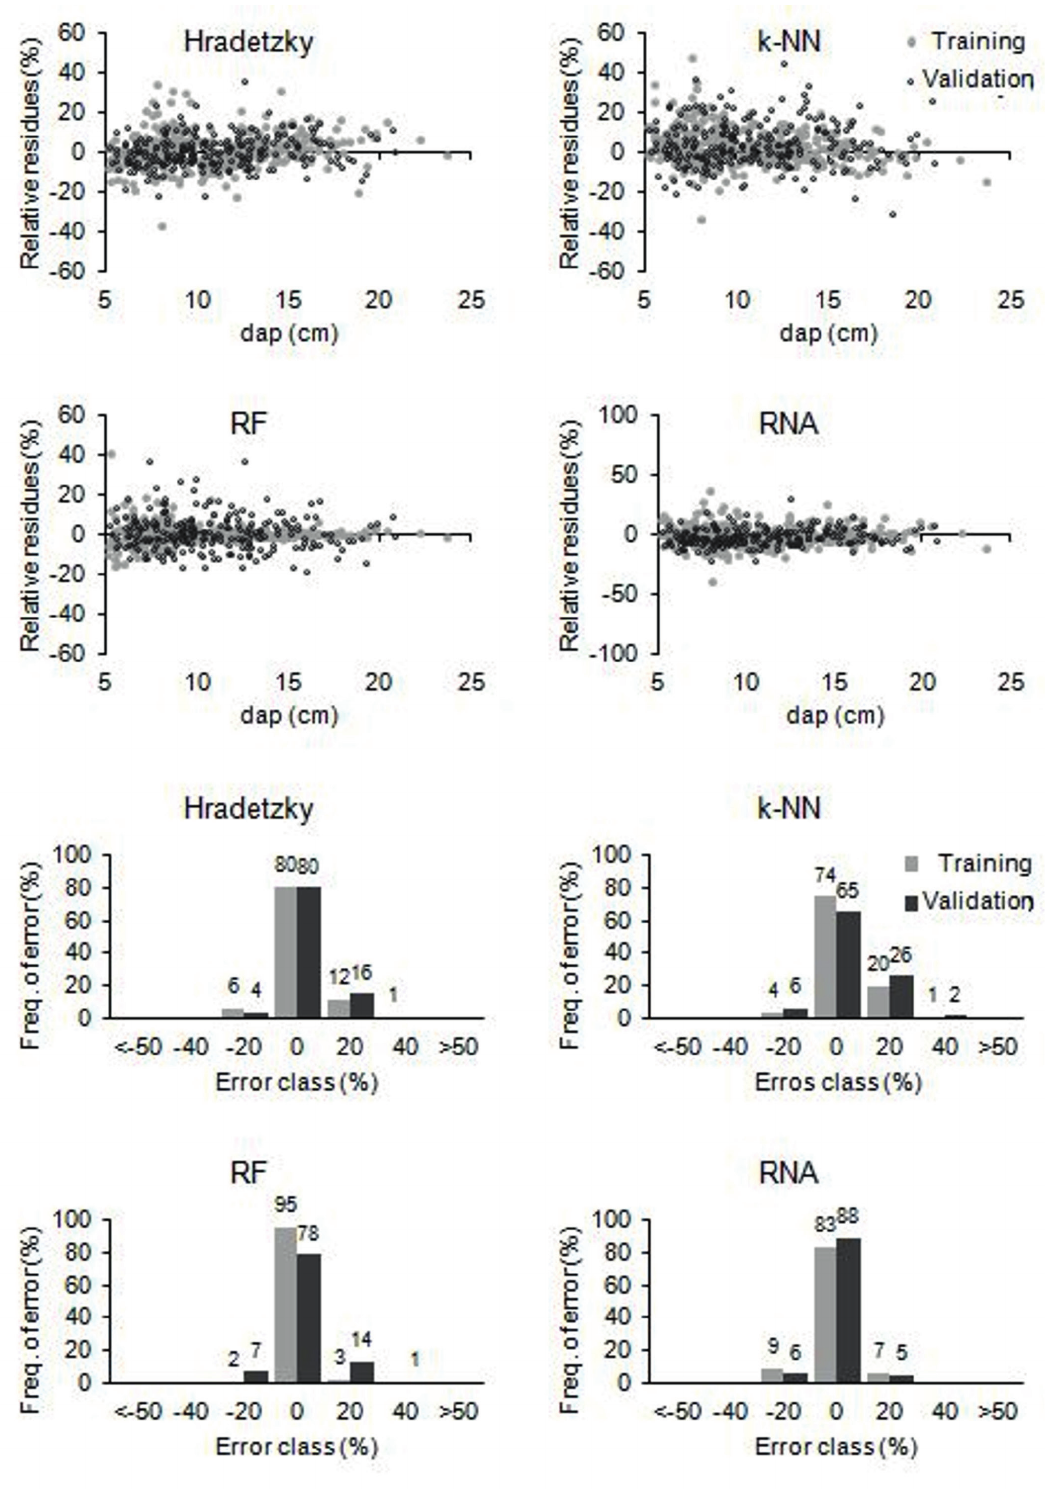
Figure 3 - Relative residues dispersion and frequency of percentual residues by error class for estimation of stem total